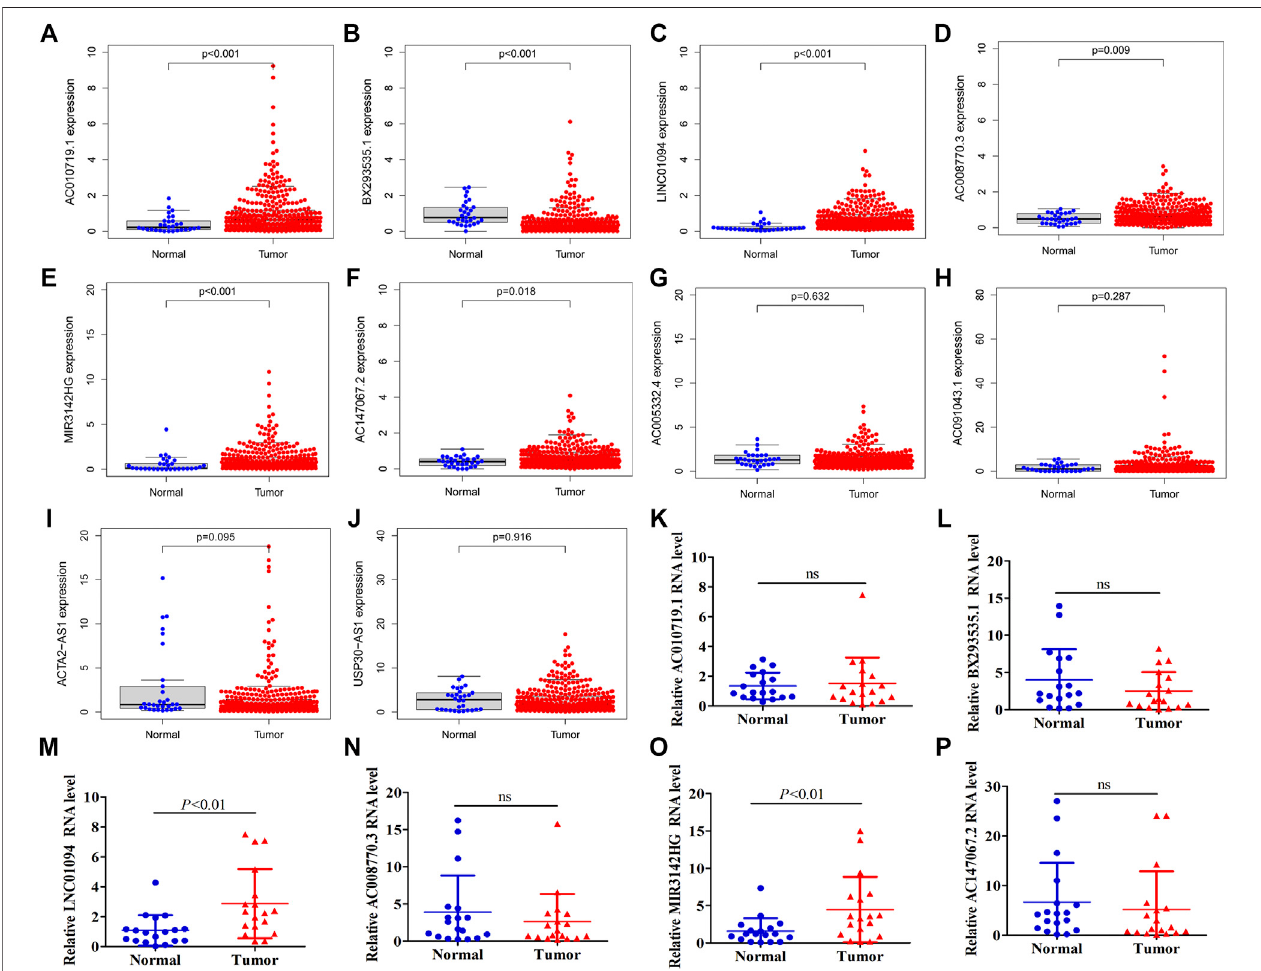
FIGURE 9| Expression validation of ten lncRNAs inourrisk model. Atotal of six lncRNAs were identi fi ed to be differentially expressed between normal tissuesand tumor tissue of the TCGA dataset (A – J) . Expression of AC010719.1, BX293535.1, MIR3142HG, LINC01094, AC008770.3 and AC147067.2 between tumor tissues and adjacent normal tissues in 18 clinic samples (K – P)